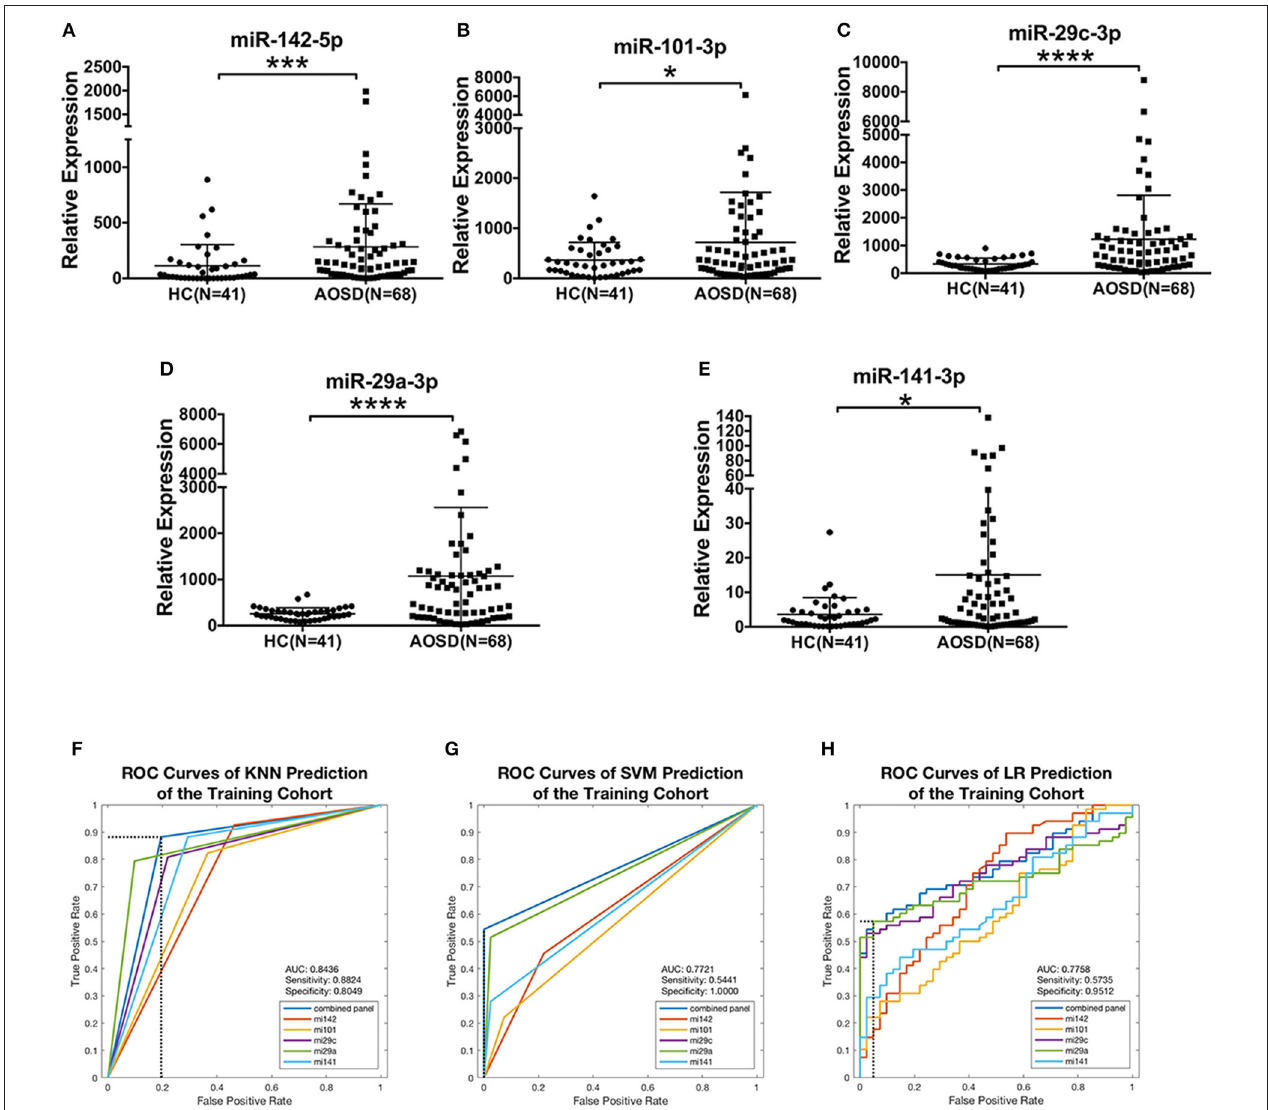
FIGURE 2 | Differentially expressed plasma miRNAs signature for AOSD diagnosis in a training set. Expression levels of (A) miR-142-5p, (B) miR-101-3p, (C) miR-29c-3p, (D) miR-29a-3p, (E) miR-141-3p were analyzed by qRT-PCR in plasma from AOSD ( N = 68) and HCs ( N = 41). The results of histograms represent the means ± SD, * P < 0.05, *** P < 0.001, **** P < 0.0001. (F-H) ROC analysis for individual miRNAs and combined miRNA panel was analyzed by KNN (F) , SVM (G) , and LR (H) analysis.